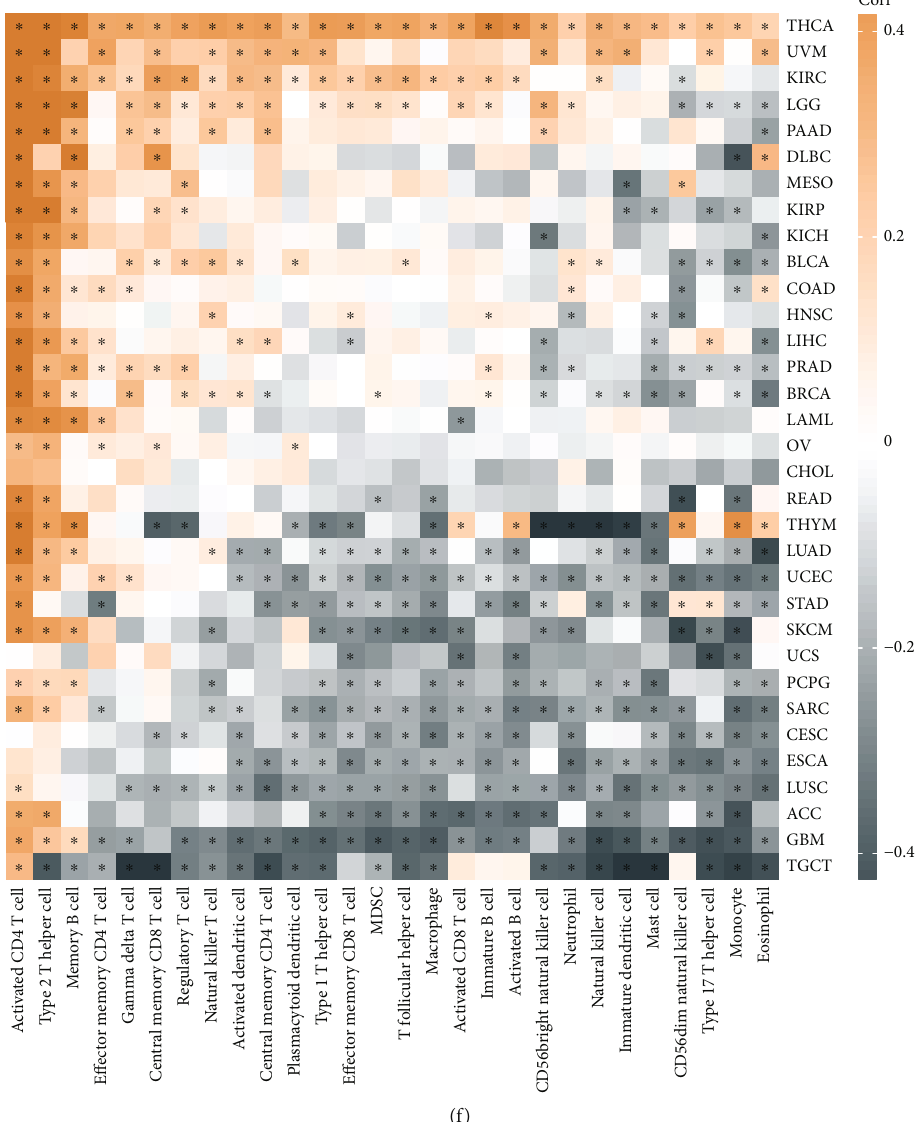
Figure 1: Pan-cancer immunological correlation with gene NCAPG. (a) Correlation between NCAPG and immunomodulators (chemokines, receptors, MHC, and immunostimulants). (b – e) Correlation between NCAPG and four immune checkpoints, namely, PDCD1, CTLA4, CD274, and LAG3. Points represent the cancer types. The y -axis represents the Pearson correlation coe ffi cient, while ( P value). (f) Spearman correlation coe ffi cients between NCAPG gene expression and 28 tumor-associated the x -axis represents -log 10 immune cells in 33 di ff erent cancer types are represented by colors. Asterisks indicate statistically signi fi cant P values for Spearman correlation analysis ( ∗ represents P < 0 : 05